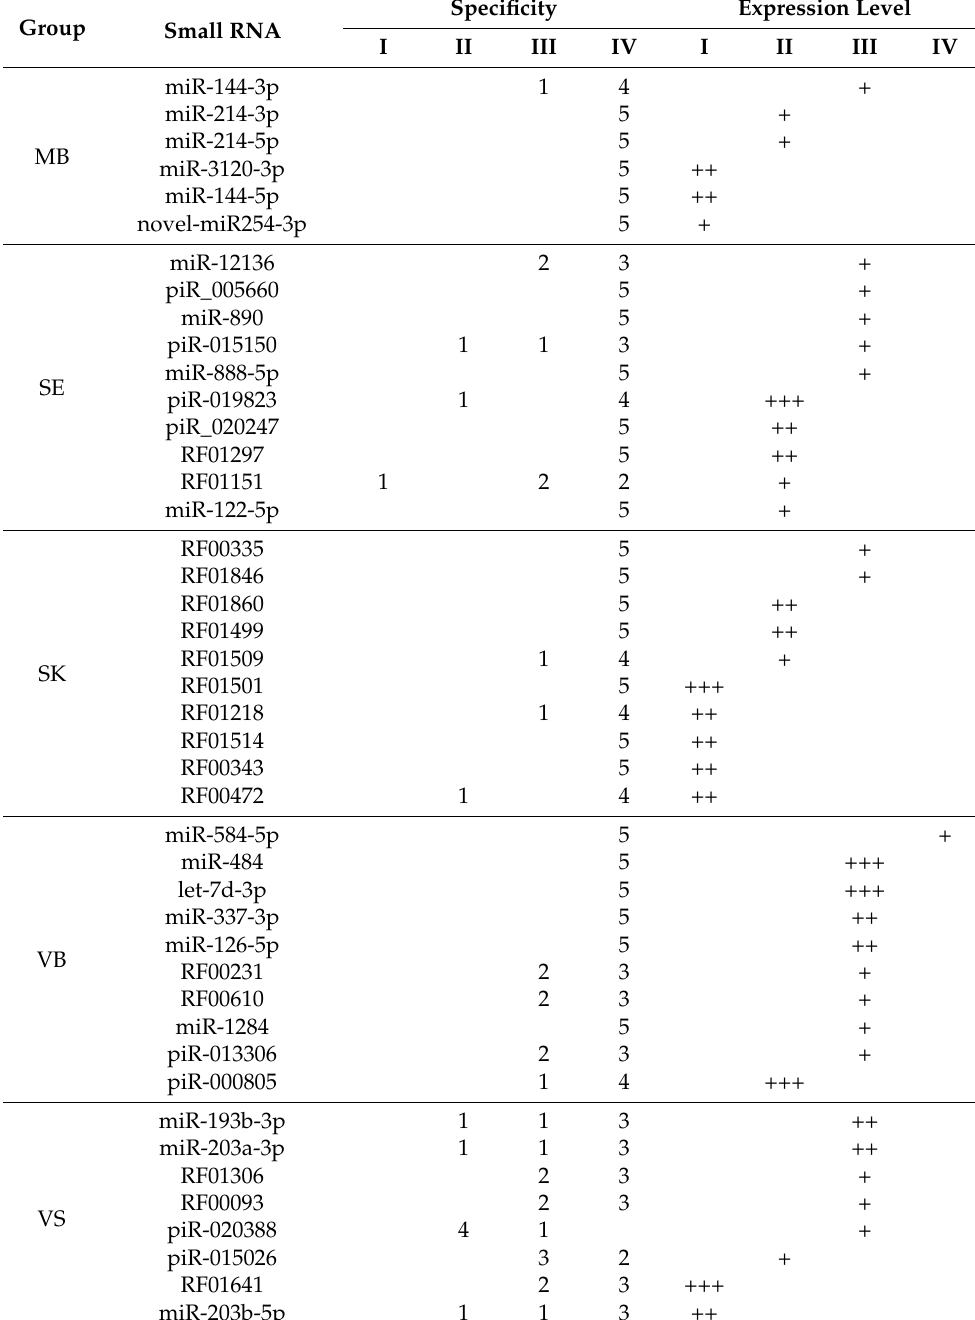
Table 3. The specificity and expression level of the top 10 ASMs screened in five body fluids/tissue. Group Small